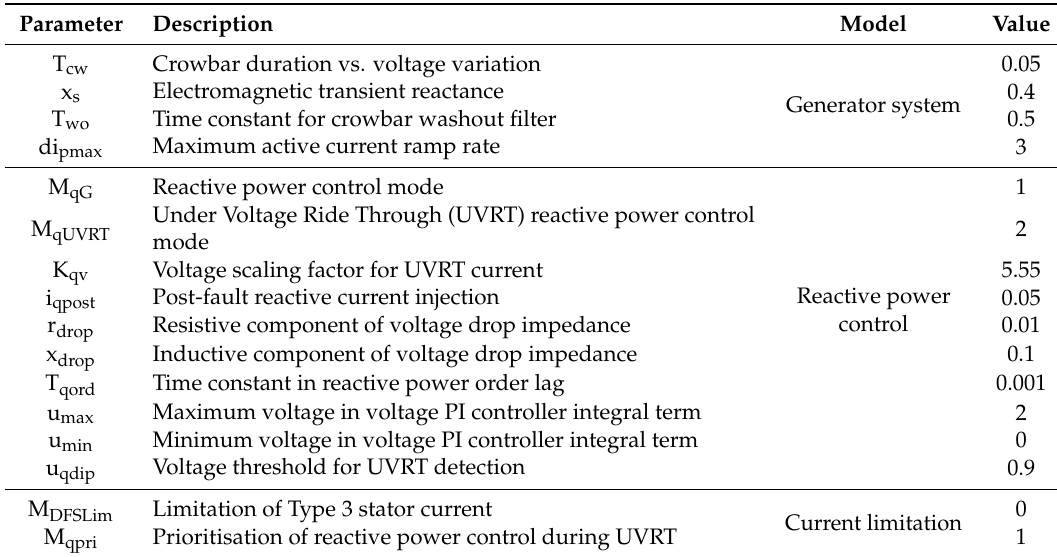
Table 2. Main parameters of the generic Type 3 WT